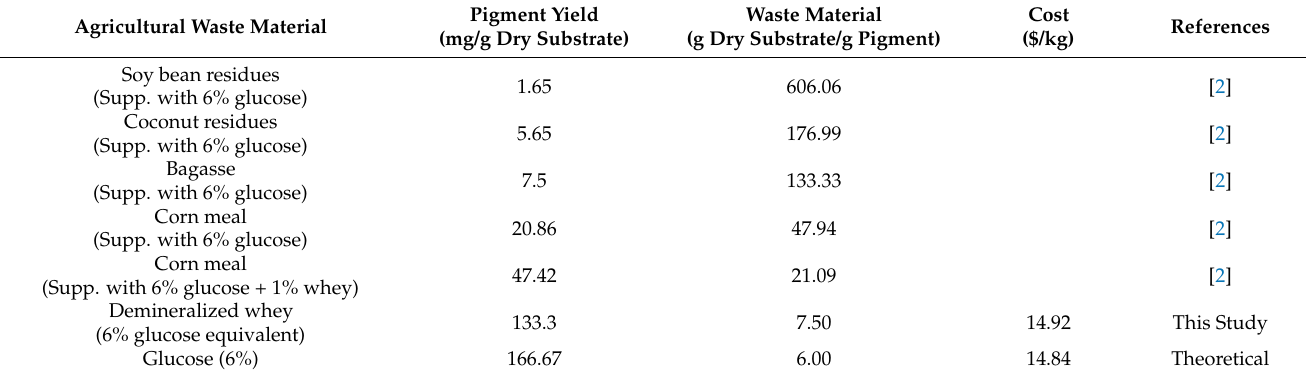
Table 1. Pigment yields and necessary waste material for red pigment